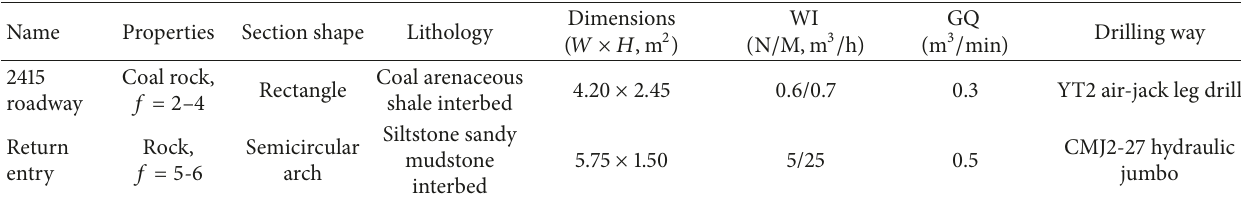
Table 4: Main parameters of the industrial test tunnels.